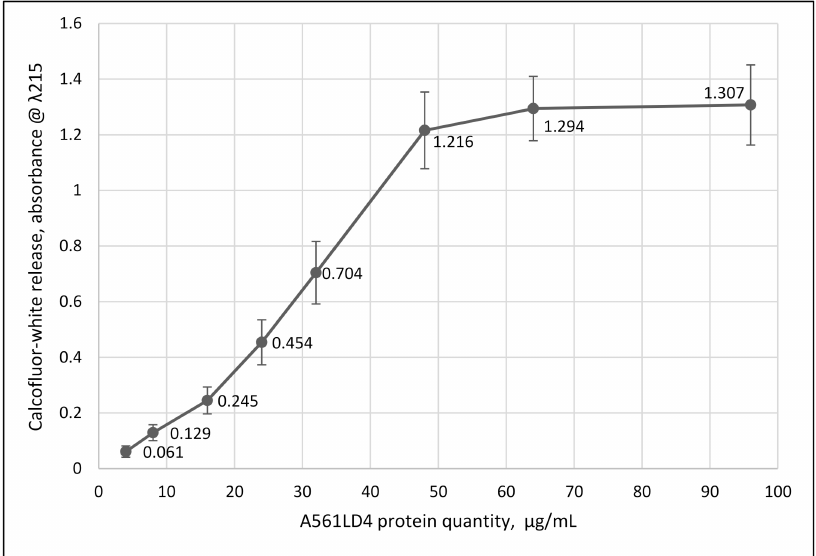
Figure 3. Specific activity of A561L D4 assayed by CFW release. Ghost chlorella cells (at a concen- tration of 5 × 10 7 /mL) stained with CFW were treated with the specified amount of recombinant A561L D4 for 1 h, then spun at 16,000 × g for 15 min. The supernatant fraction was removed and CFW release was measured at λ = 215 nm. Results are plotted as mean ± standard deviation ( n = 10), p -value